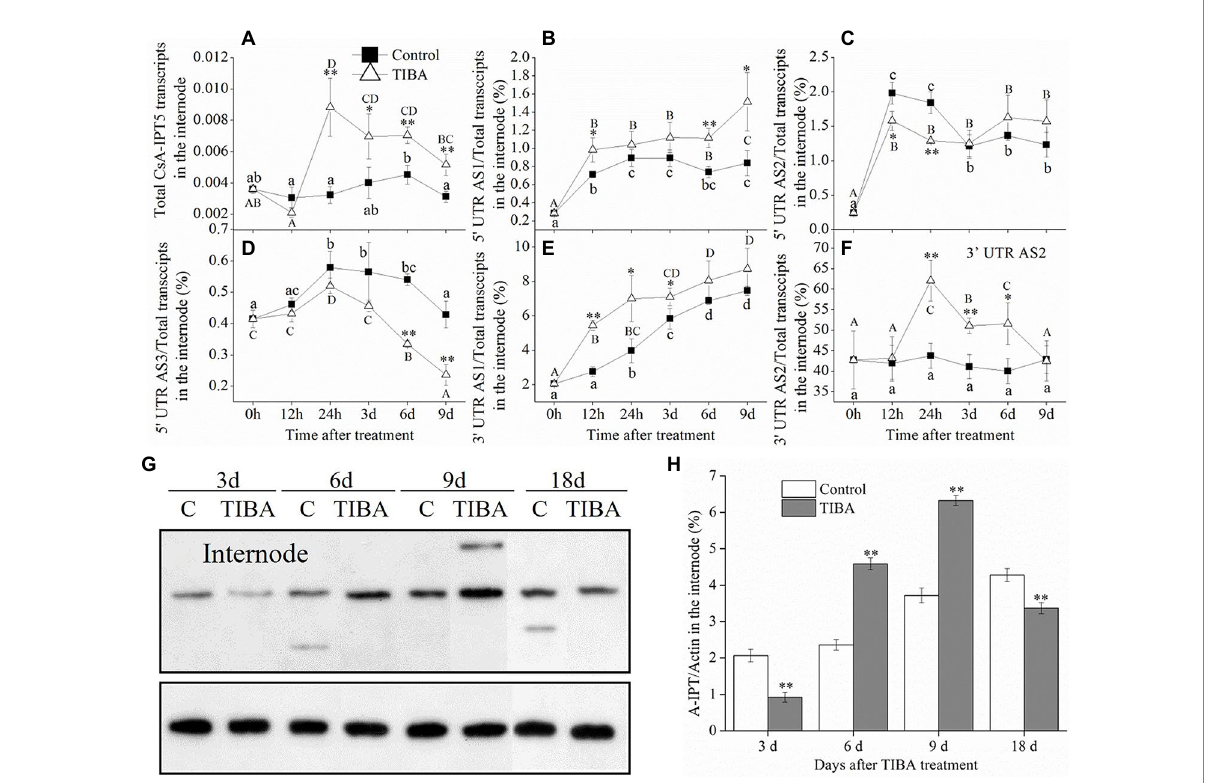
FIGURE 2 Expression levels of CsA-IPT5 transcripts and CsA-IPT5 protein in the internode at different time points stimulated by exogenous TIBA spraying. The expression levels of total CsA-IPT5 transcripts (A) and the expression ratio of each CsA-IPT5 splice variation (B–F) in the internode at different time points stimulated by TIBA spraying. Western blot (G) and ‘CsA-IPT5/Actin’ (H) display the CsA-IPT5 protein expression in the internode induced by TIBA. Data are means ± SD ( n = 3 or 6). For each figure, asterisks show marked differences in each index between TIBA treatment and the control at each time point (** p < 0.01; Student’s t